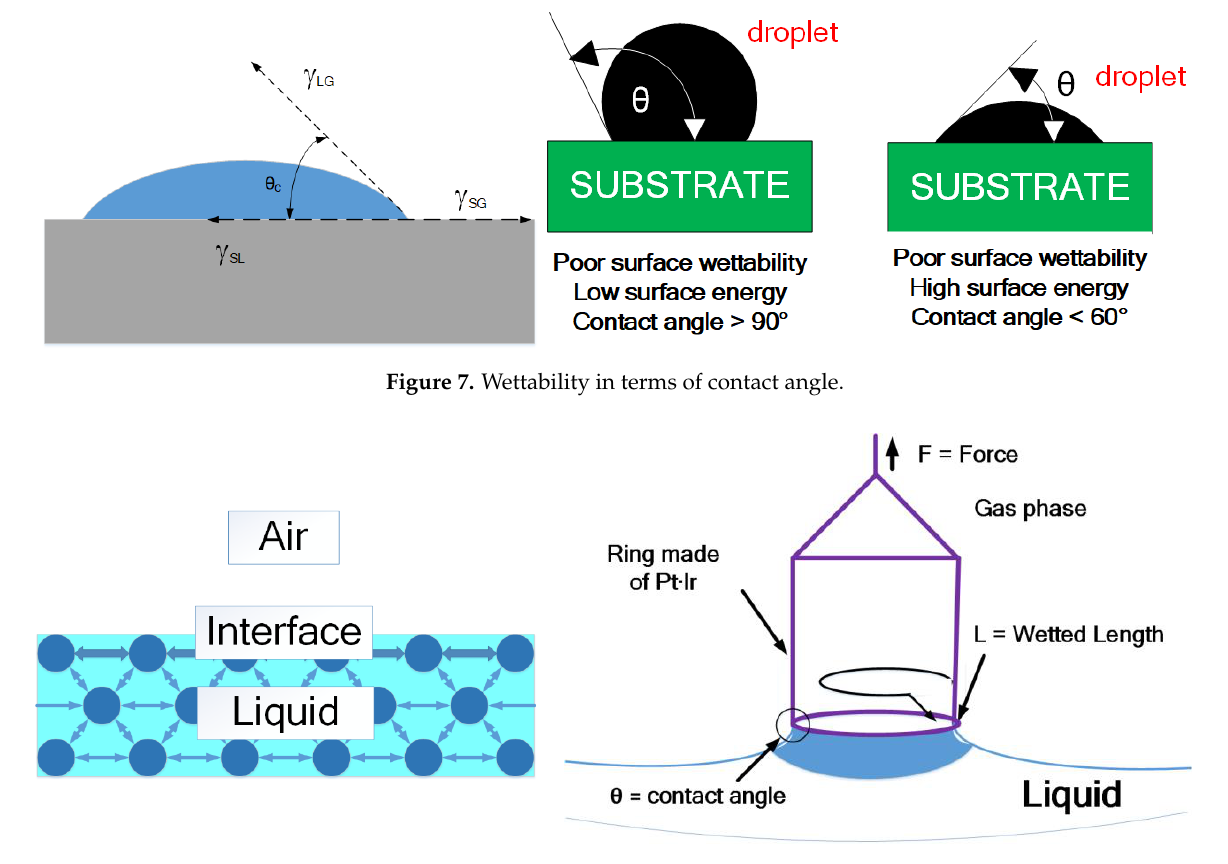
Figure 8. Surface tension.